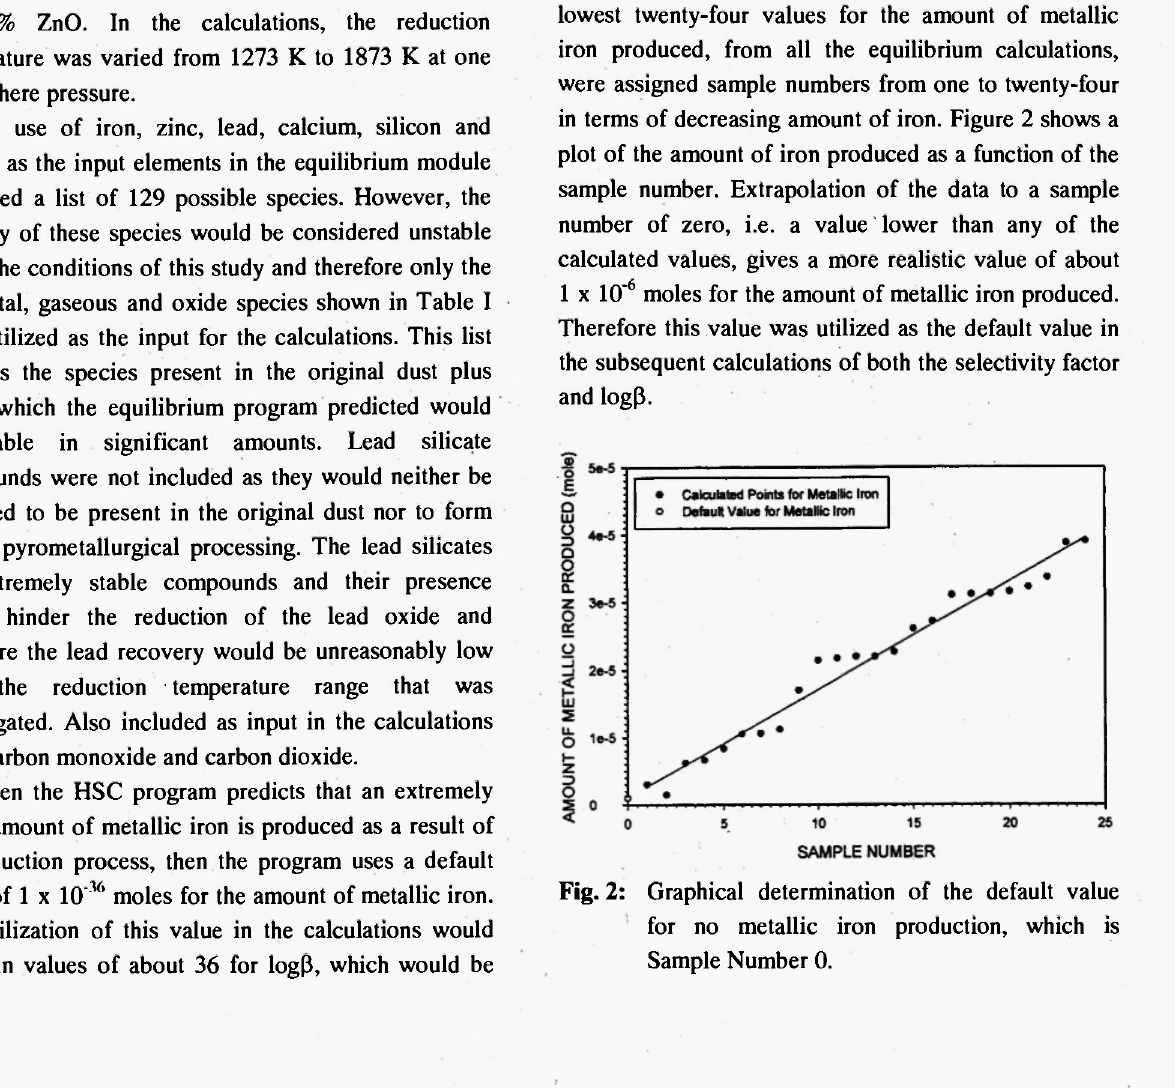
Fig. 2: Graphical determination of the default value for no metallic iron production, which